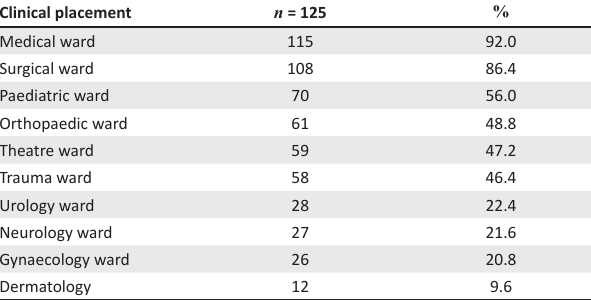
TABLE 1: Respondents’ clinical placement